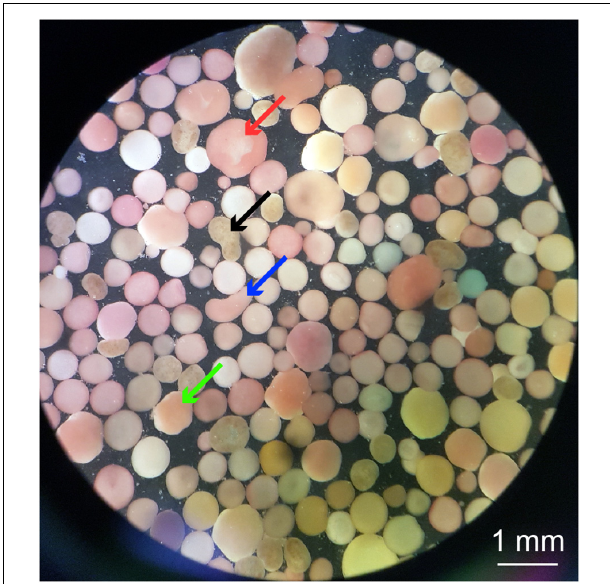
FIGURE 4 | Microscope image of a wild coral-spawn slick sample taken from one of the culture tanks approximately 36 h following spawning. The sample indicates a variety of coral species found in a wild coral-spawn slick, recognized through the range of sizes, colors, and those that have zooxanthellae already present (e.g., black arrow) or absent (e.g., red, blue and green arrows). Observed are a range of developmental stages of intact embryos to larvae, including: morula (e.g., green arrow), prawn chip (e.g., red arrow), and elongated planulae (e.g., black and blue arrows) (terms following Jones et al.,